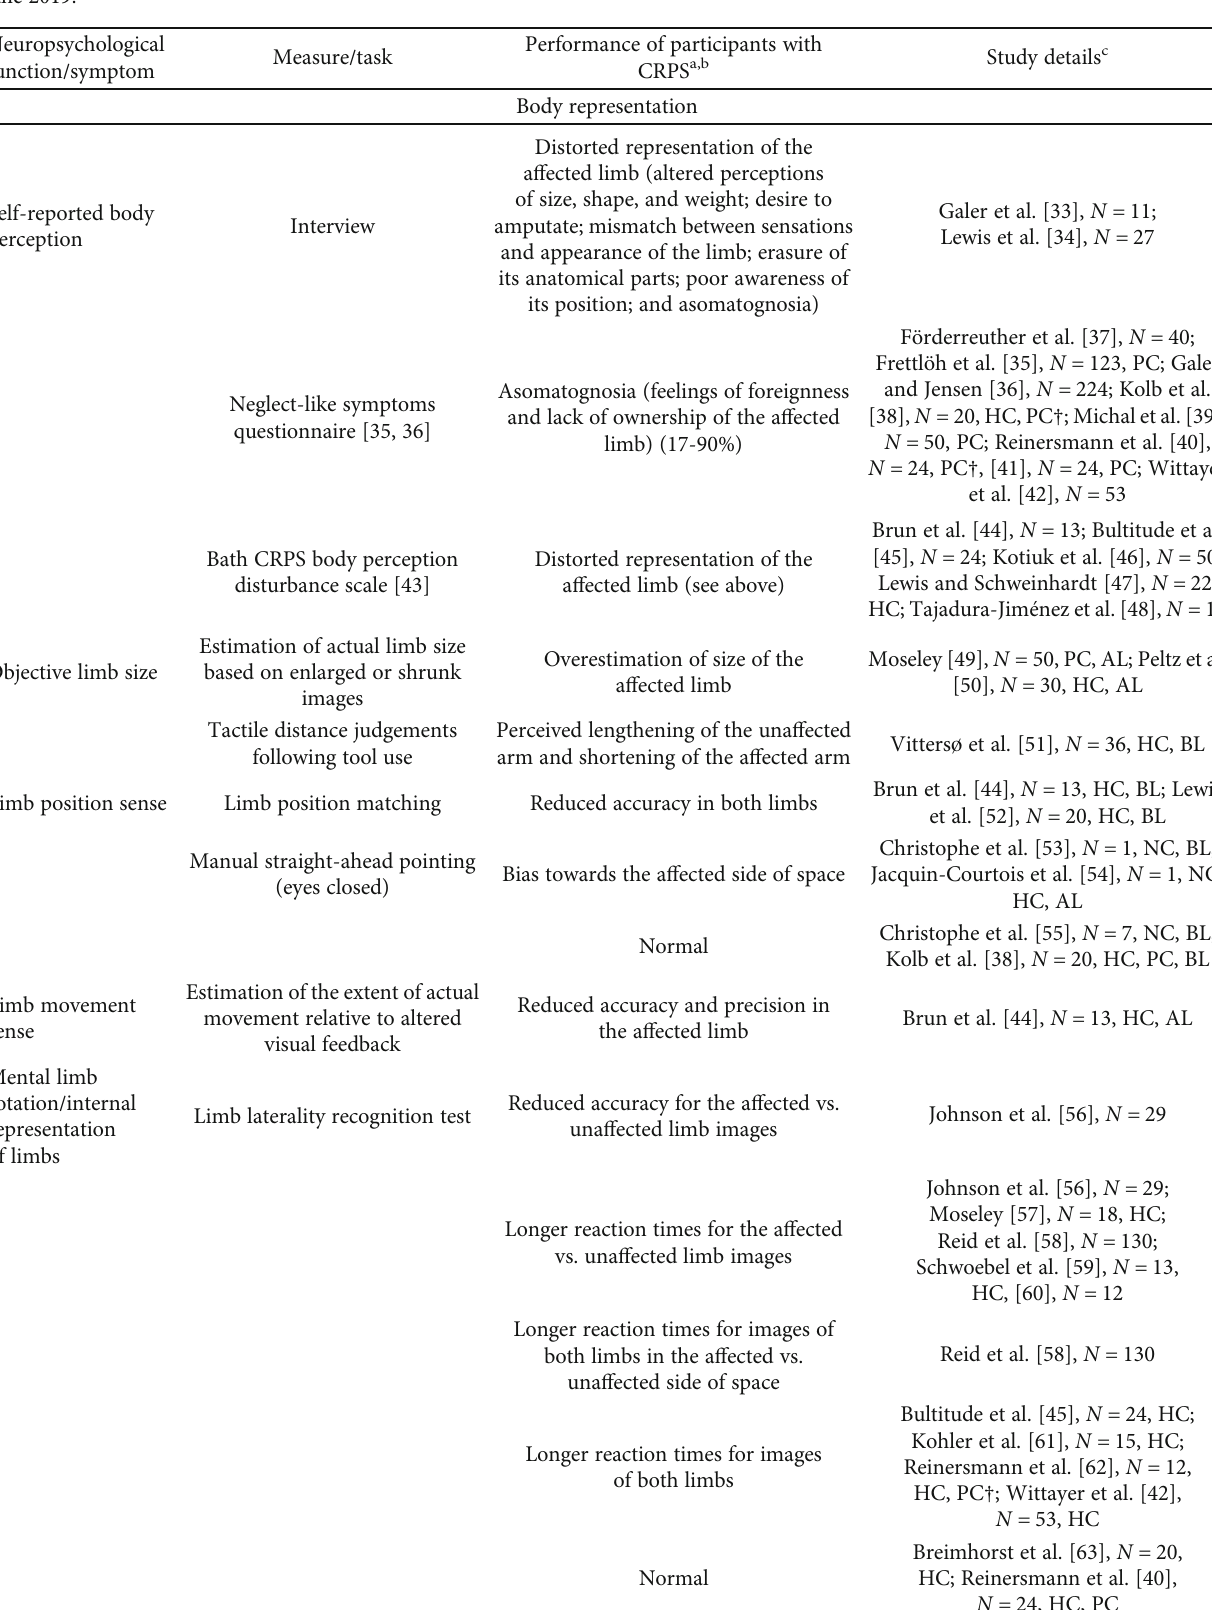
Table 2: Summary of neuropsychological functions investigated in people with CRPS in research studies published between July 1995